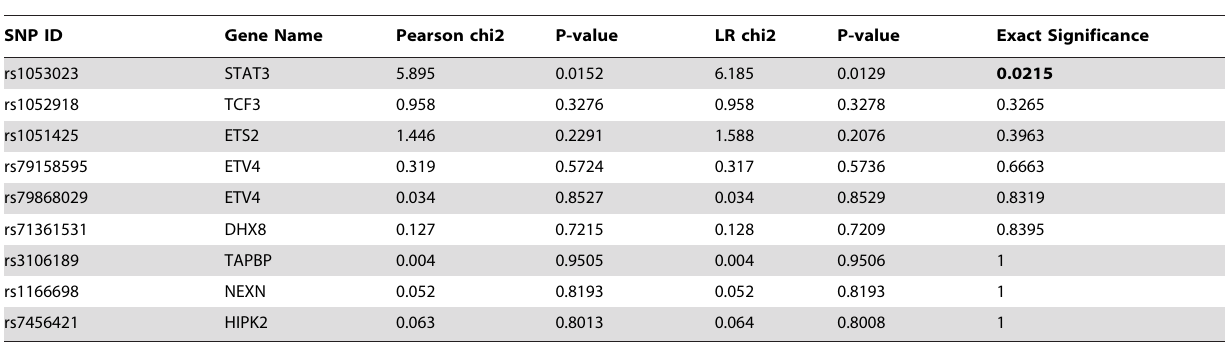
Table 9. The Hardy-Weinberg equilibrium of the